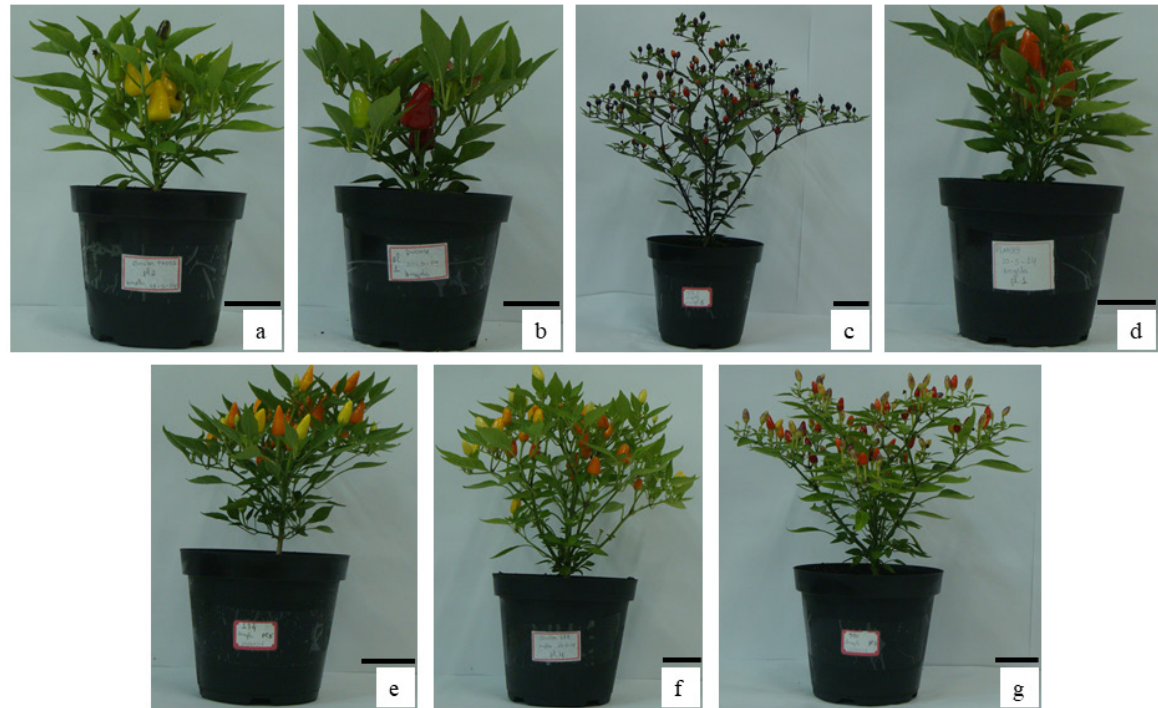
Figure 1 - Genotypes from Capsicum annuum L. a – UFPB001; b – UFPB004; c – UFPB77.3; d – UFPB099; e – UFPB134; f – UFPB137 and g – UFPB390. Bar =